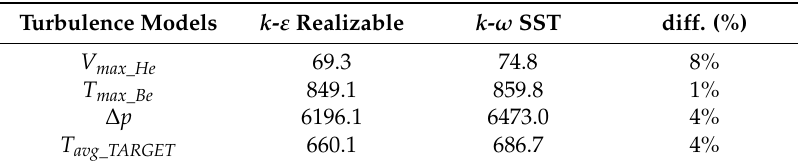
Table 5. Sensitivity analysis on turbulence